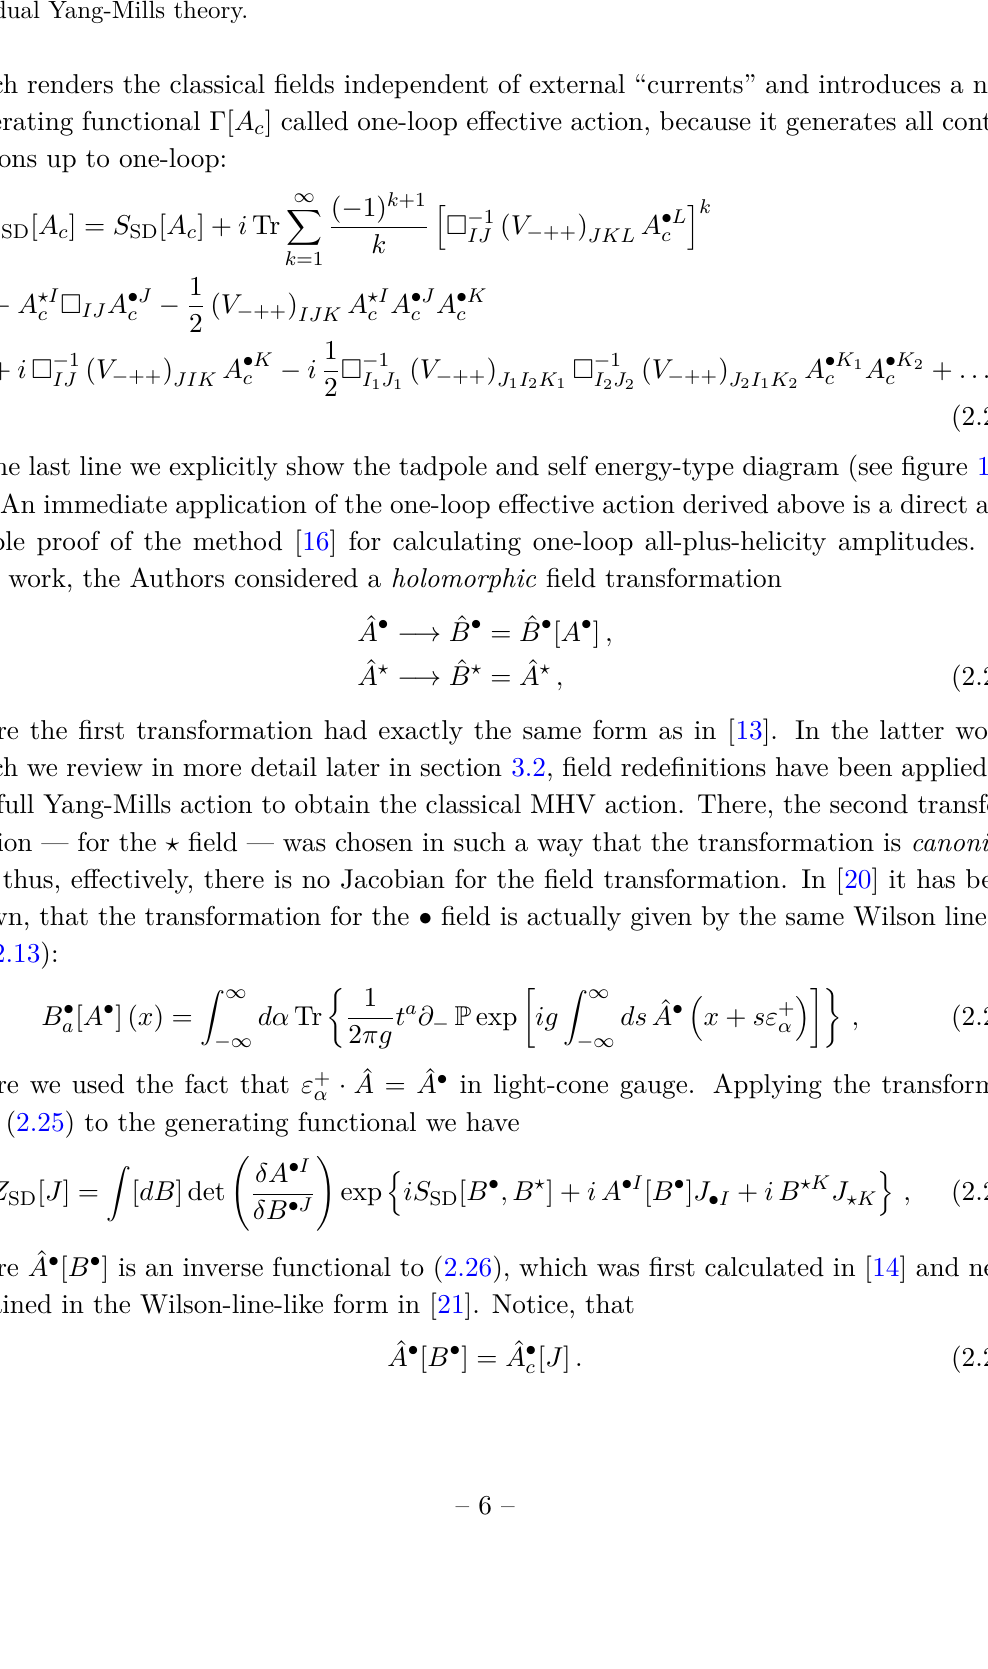
Figure 1 . The diagrammatic content of the logarithm term in the one-loop effective action for the self-dual Yang-Mills